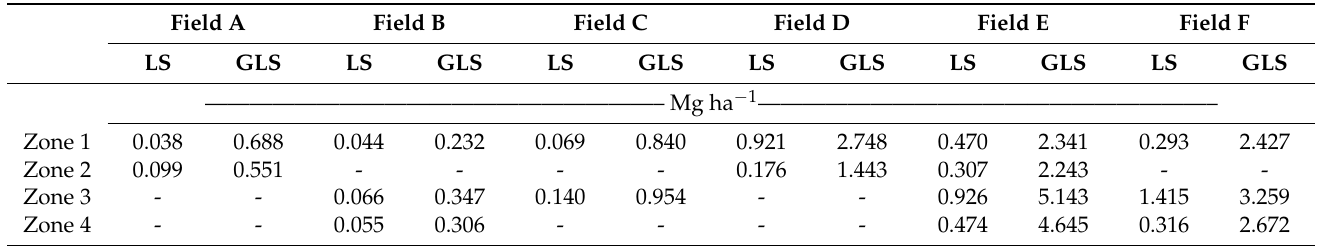
Table 3. Root mean squared errors (RMSEs) were calculated per management zones (Zone 1, 2, 3, and 4) and field (Field A, B, C, D, E, and F) comparing treatment effect estimates using 60% and 100% of the data. Two approaches, least squares (LS) and generalized least squares (GLS) approaches, were used to estimate the treatment